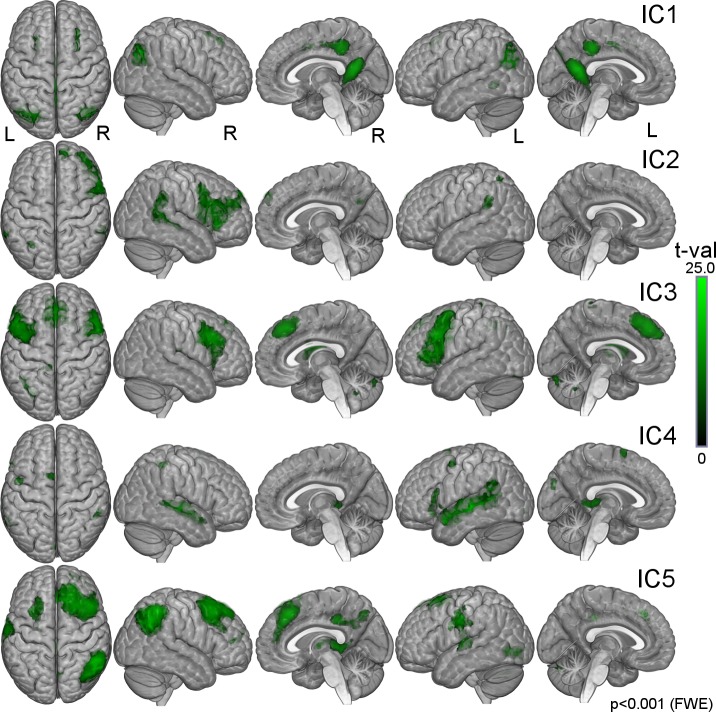
Visualization of TOP-5.Spatial t-value maps of TOP-5 ICs sorted from IC1 (top row) to IC5 (bottom row) and overlaid on partially transparent 3D brain template. Statistical threshold is set to p<0.001 (FWE) with the minimum cluster extent of 50 normalized voxels.